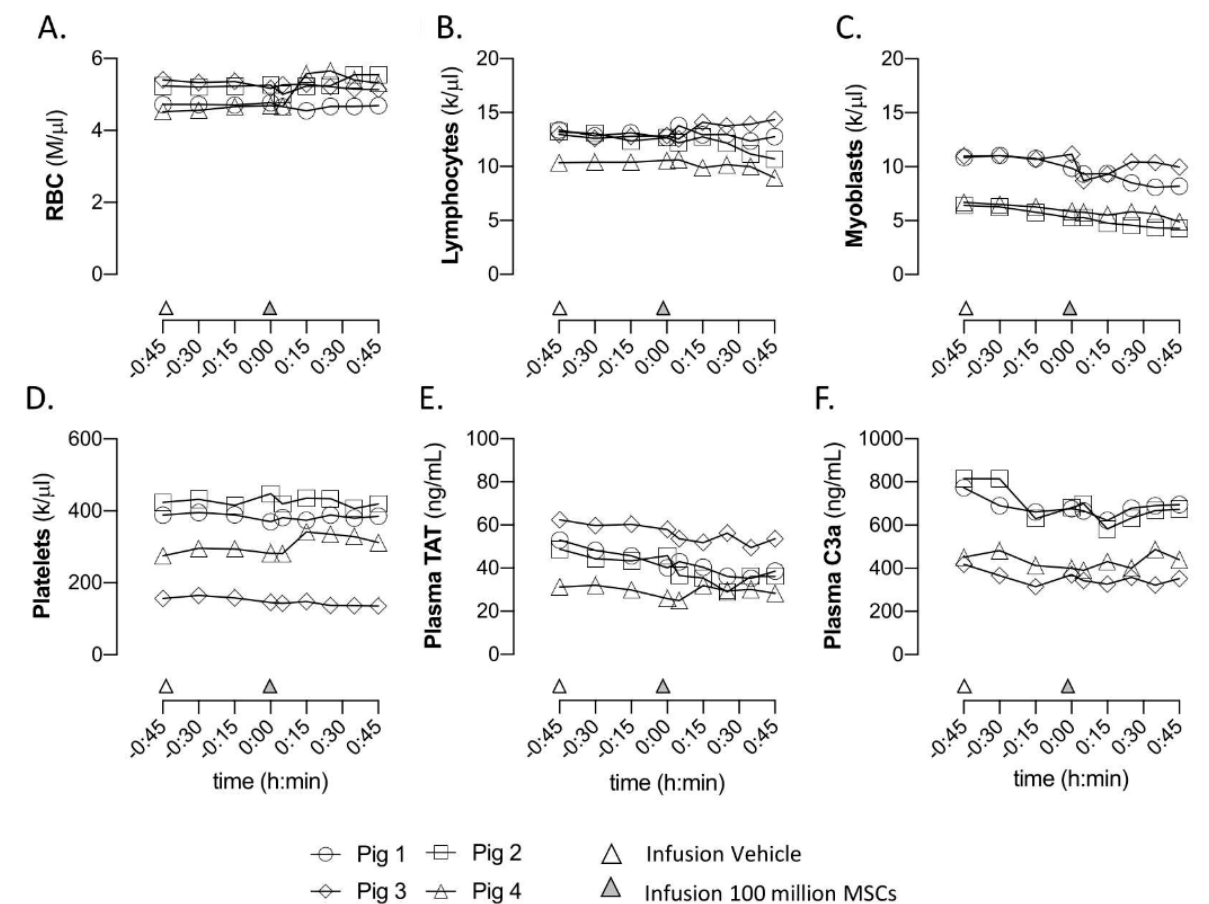
Figure 5. Blood parameters that were measured directly after intra-renal arterial administration of vehicle (PBS; at t = − 45 min) and one hundred million MSCs (at t = 0). ( A ) The number of red blood cells. ( B ) The number of lymphocytes. ( C ) The number of myoblasts. ( D ) The number of platelets. ( E ) The plasma levels thrombin–antithrombin complex (TAT). ( F ) The plasma levels of complement Component C3a. Graphs present the individual values of each animal.